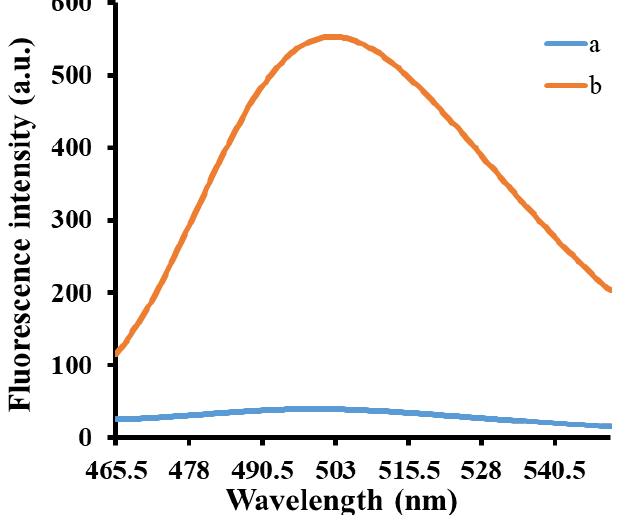
Figure 1. The feasibility test of the proposed strategy. ( a ) cDNA + KF polymerase + NtBstNBI + TdT; ( b ) cDNA + miRNA-21+ KF polymerase + NtBstNBI + TdT. Concentrations of cDNA, KF polymerase, NtBstNBI and TdT were 60 nM, 100 U/mL, 40 U/mL and 280 U/mL, respectively.